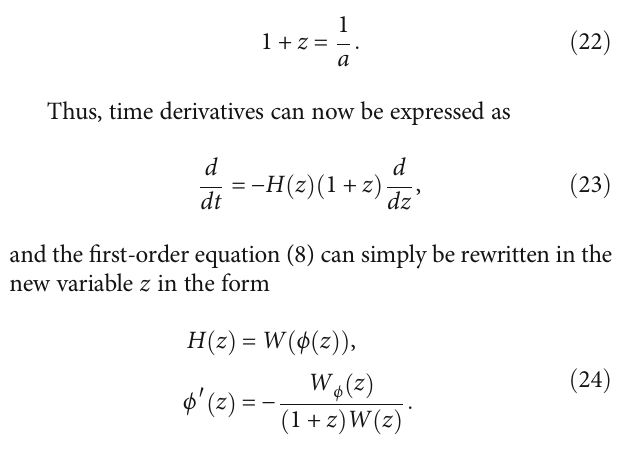
Figure 2: The decelerate parameter q (21) (a) and dark energy equation of state ω curve), and β = 15 : 3 , with α = 0 : 08 and η = 0 : 06 (red curve). The Hubble parameter H (c) and scalar fi eld ϕ (d) with the same values of parameters. All the cosmological observables are given as functions of the redshift z